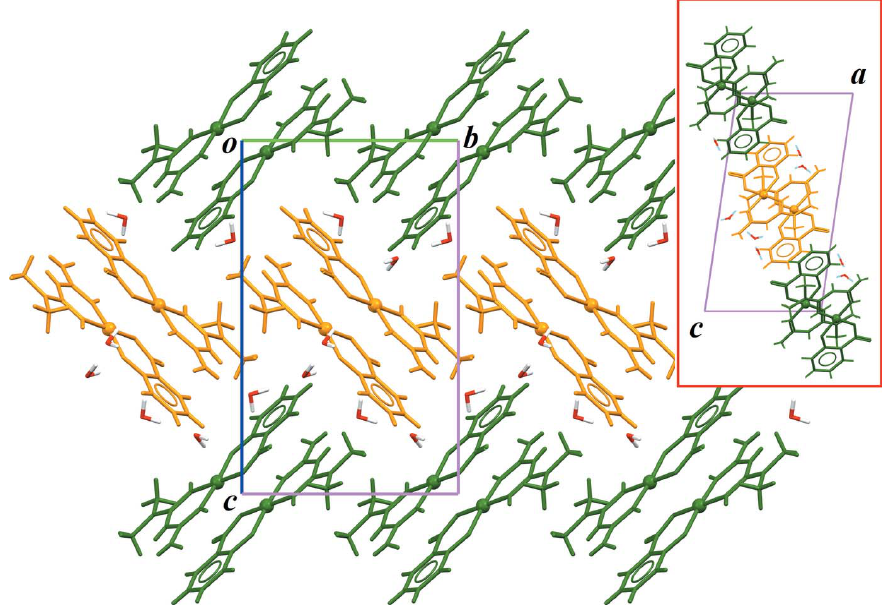
Figure 2 The crystal structure of the title compound, viewed down [100], with a colour scheme emphasizing the stacks formed along [010], and the distribution of water molecules. The inset is the same part of the crystal structure viewed along the stacking direction [010].